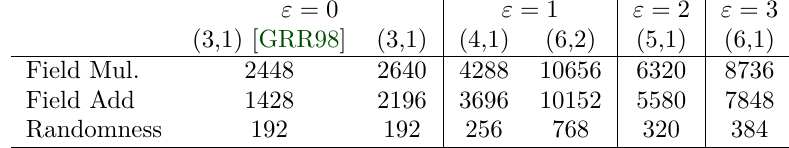
Table 6: Total number of operations for different ( n, d ) -scenarios for one round of AES-128. ε = 0 ε = 1 ε =